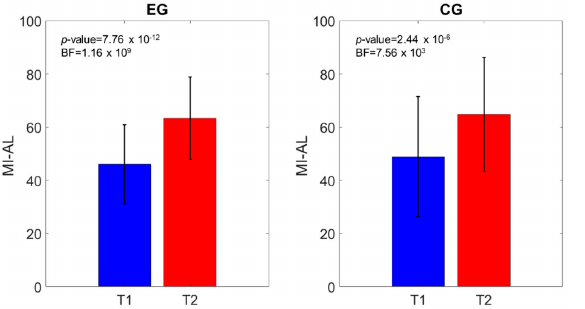
Figure 3. Motricity Index of the affected lower Limb (MI-AL) comparison of the scores at T1 and T2. The p -value and the BF of the intragroup effects are shown.